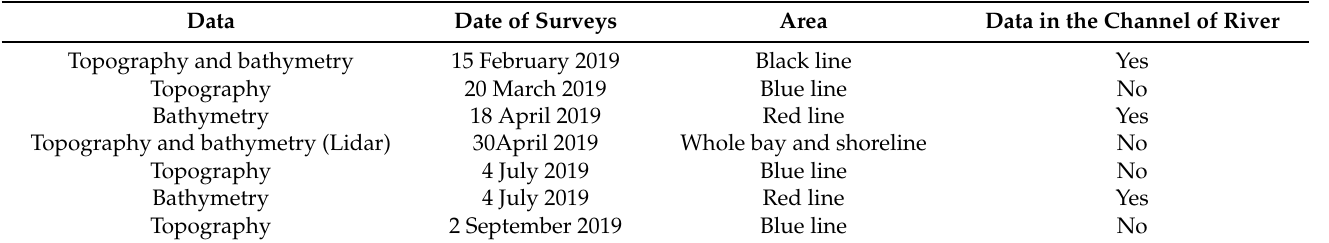
Table 1. The different topographic and bathymetric